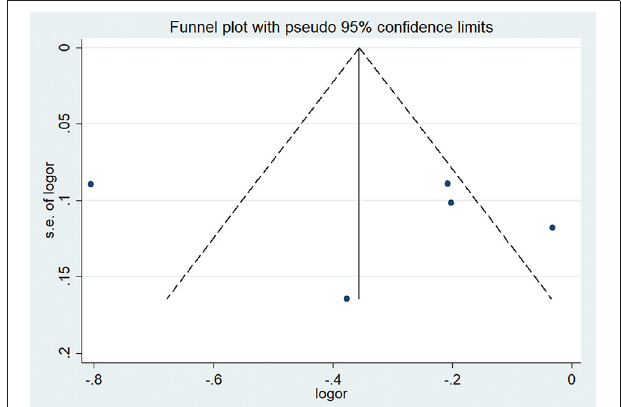
FIGURE 4 | Funnel plot of sKlotho levels and VC.